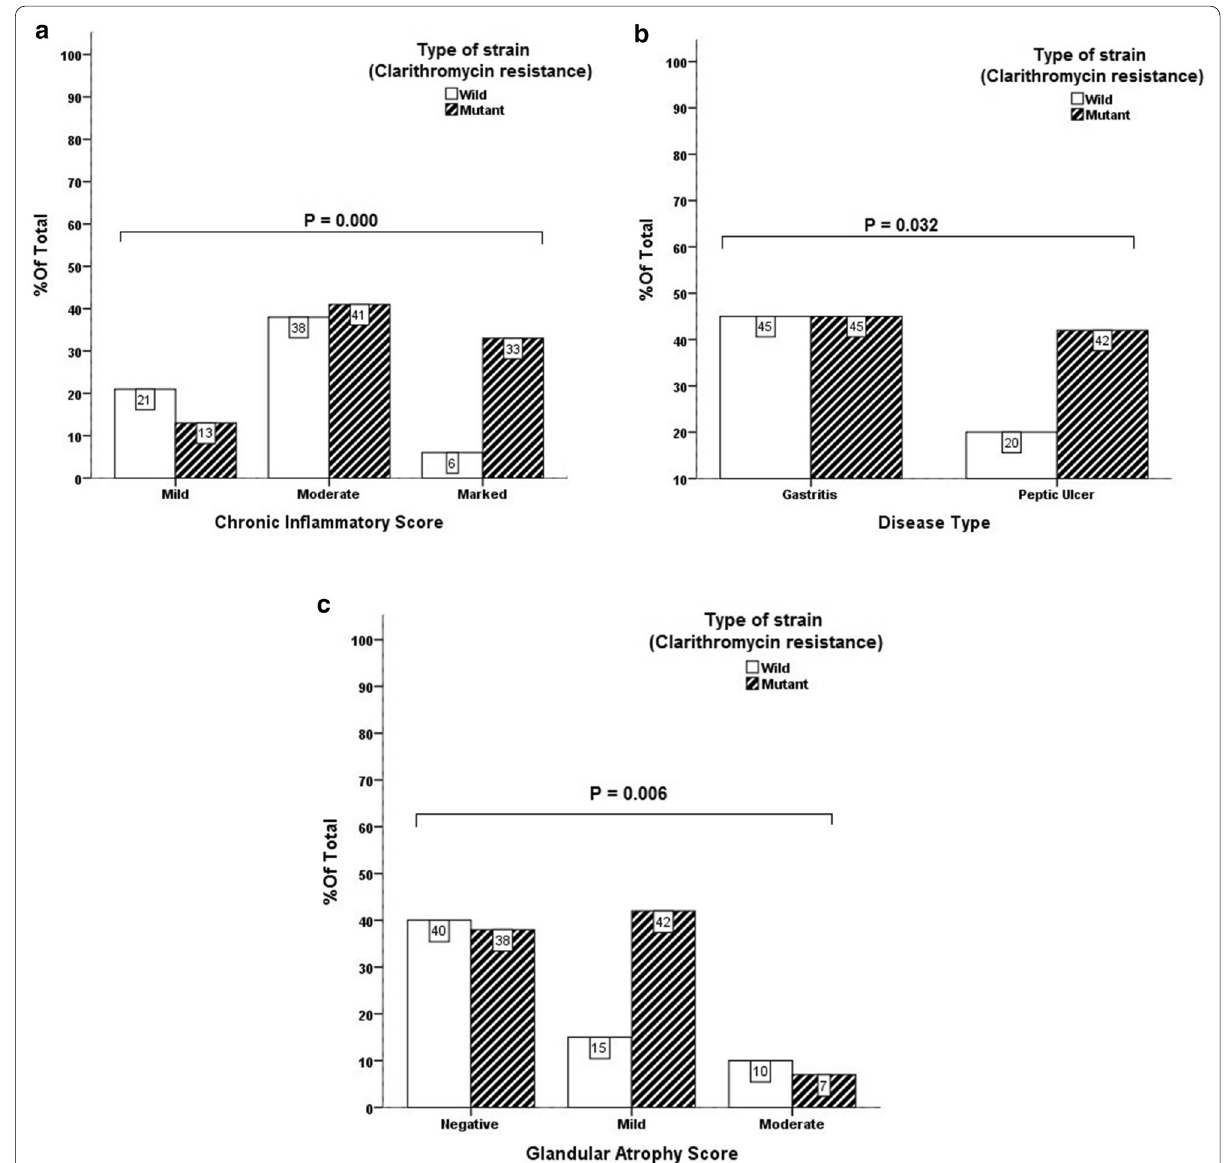
Fig. 2 Correlation among the degree of inflammation ( a ), disease type ( b ), and Glandular atrophy ( c ) with the type of isolate in terms of clarithromycin